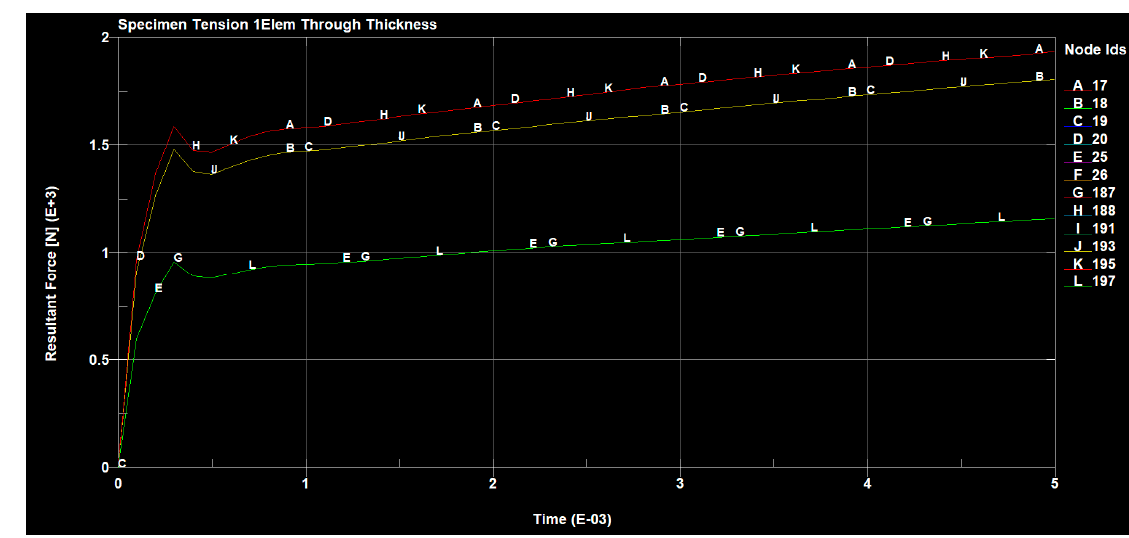
Figure 33. Total tensile forces present in the sample.